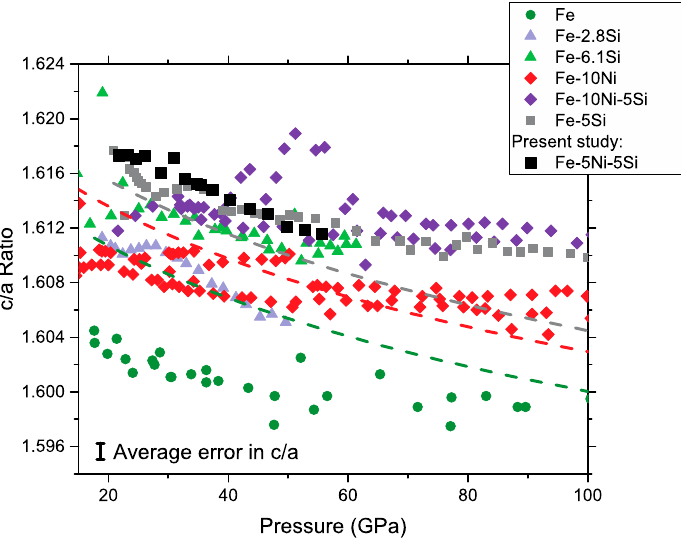
Figure 3. Axial c / a ratio of hcp alloys in the Fe–Ni–Si system at ambient temperature as a function of pressure. Legend is same as in that in Figure 2. Dashed lines are the expected c / a ratio according to the parameterization proposed in [27] for Fe (dark green), Fe–10Ni (red), and Fe–5Si (gray).